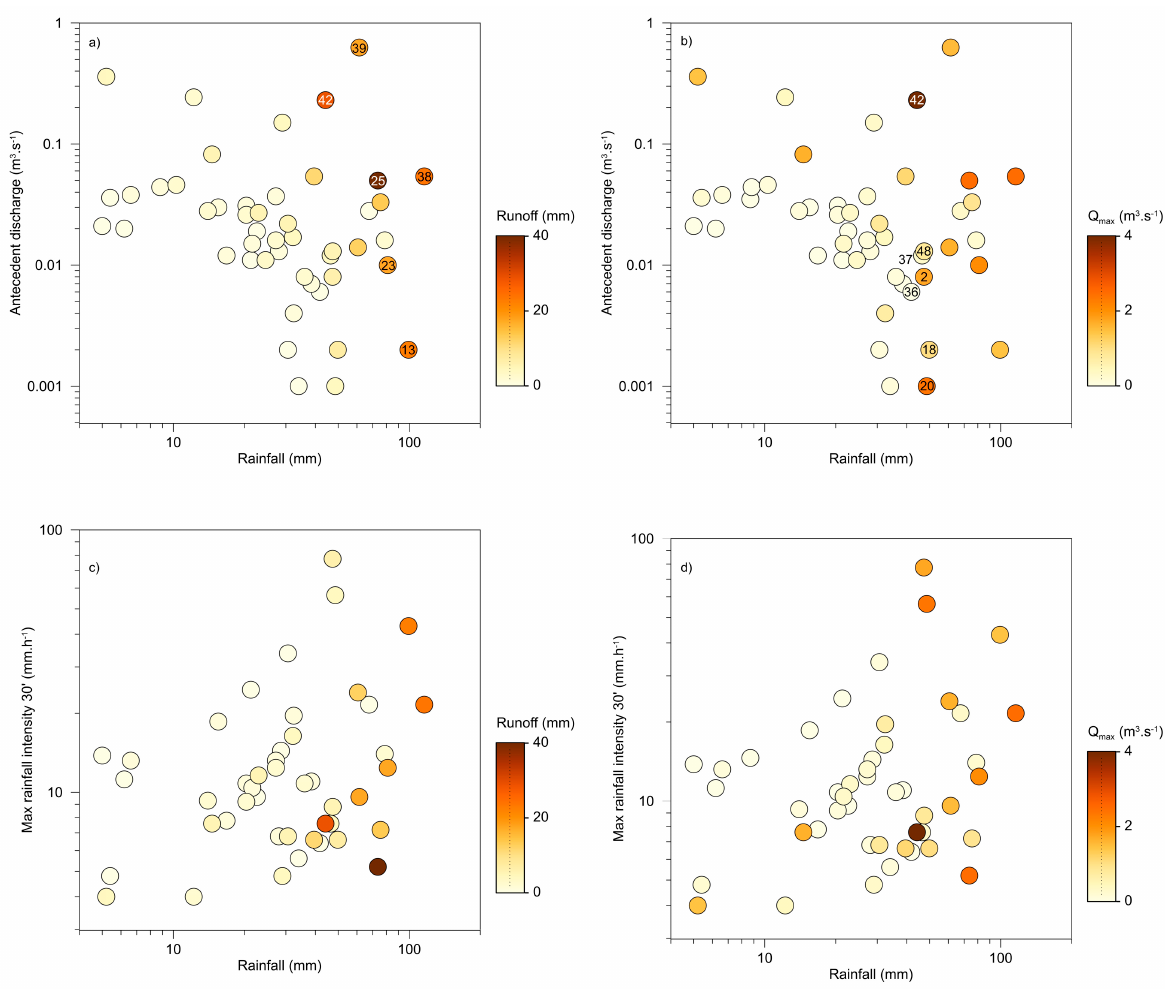
Figure 7. Multiples relationships between rainfall and R variables at the event scale at Es Fangar Creek: ( a ) rainfall-antecedent discharge-runo ff ; ( b ) rainfall–antecedent discharge-Q max relationship; ( c ) IP max 30-rainfall-runo ff and ( d ) IP max 30-rainfall-Q max . The points with an ID are depicting the